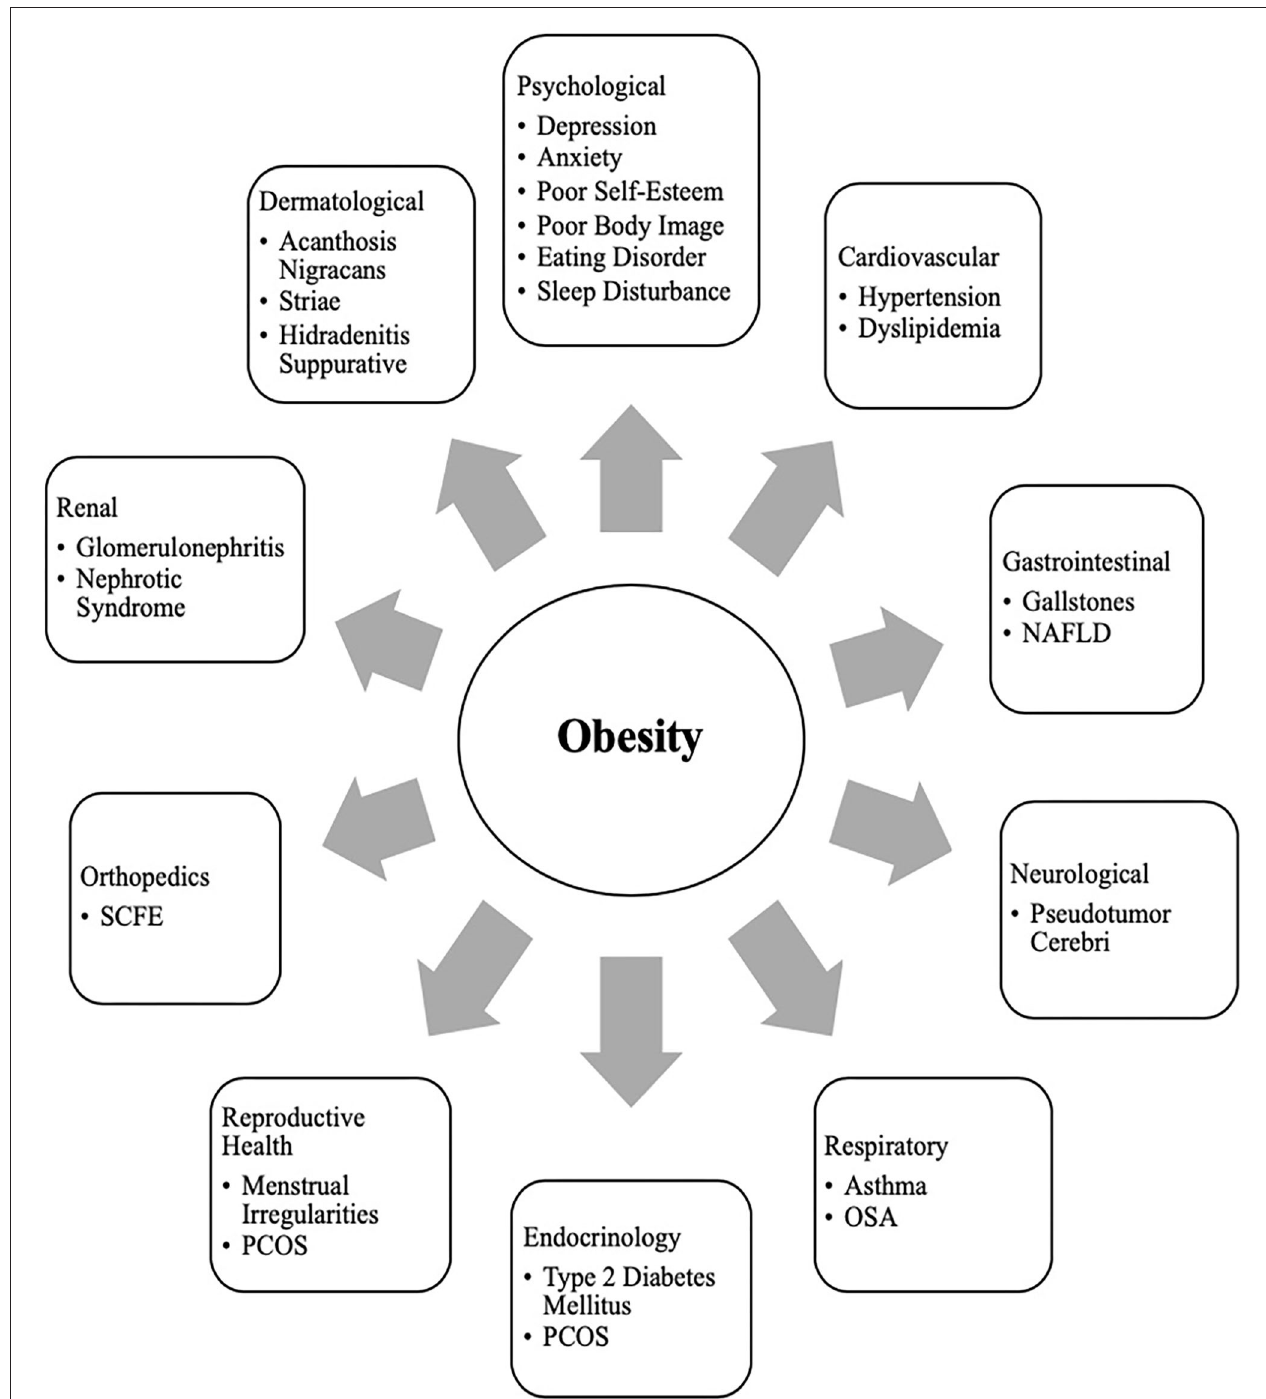
FIGURE 3 | Obesity related co-morbidities a in children and adolescents. a, NAFLD, Non-Alcoholic Fatty Liver Disease; SCFE, Slipped Capital Femoral Epiphysis; PCOS, Polycystic Ovary Syndrome; OSA, Obstructive Sleep Apnea.